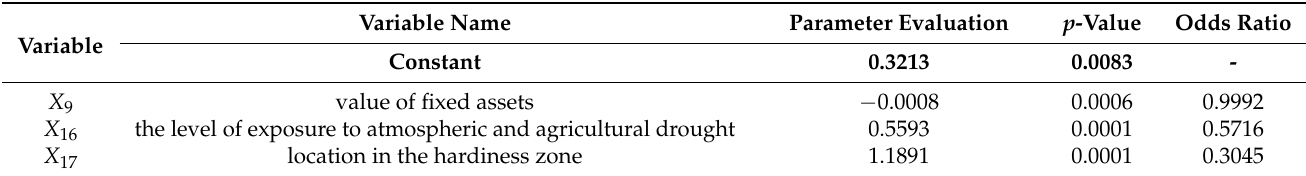
Table 4. Evaluation of logit model parameters.